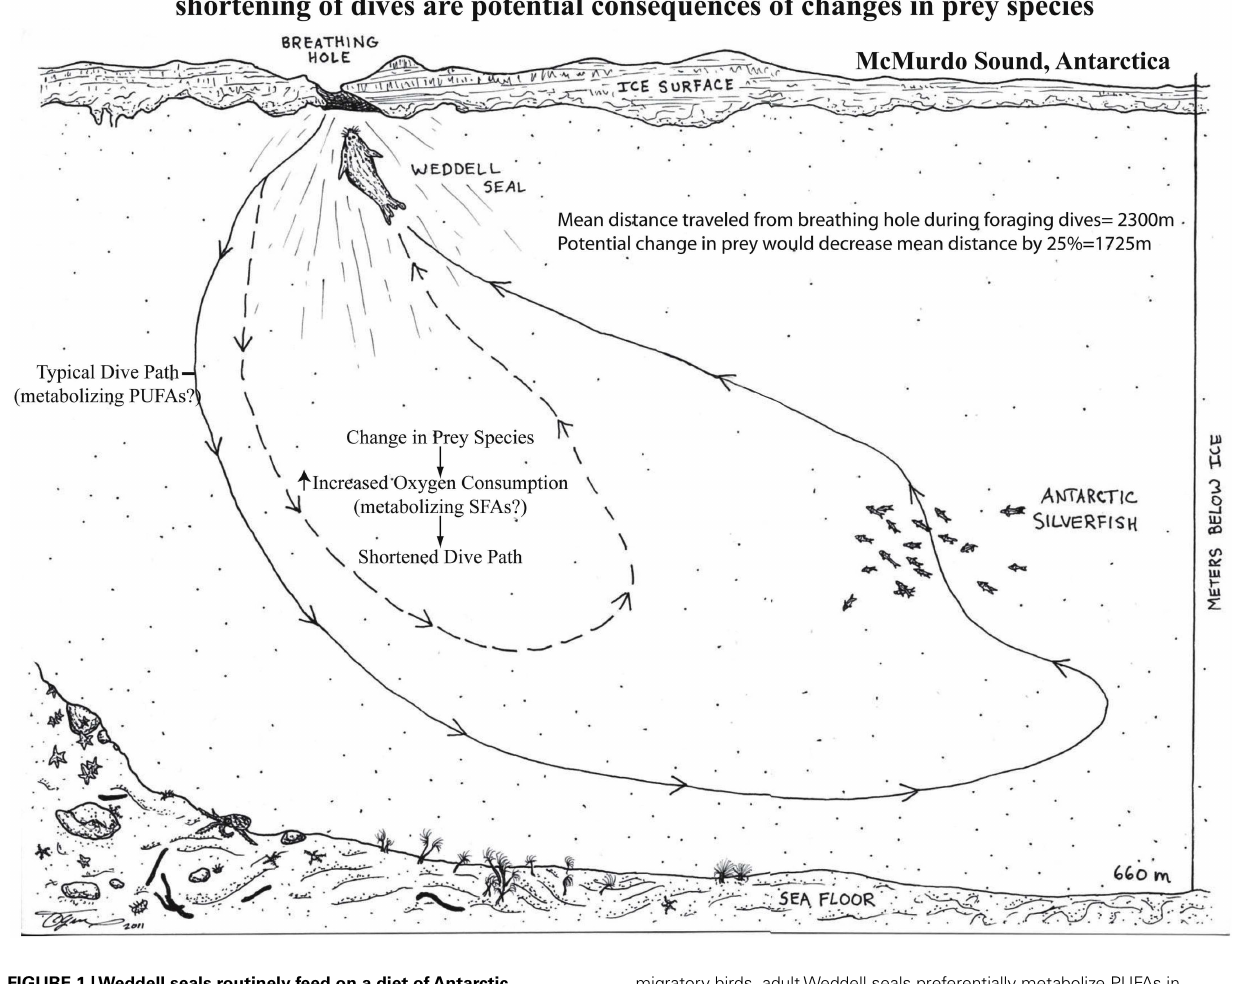
FIGURE 1 |Weddell seals routinely feed on a diet ofAntarctic silverfish ( Pleuragramma antarcticum ) that is rich in unsaturated fatty acids. Recent data indicates that similar to long distance